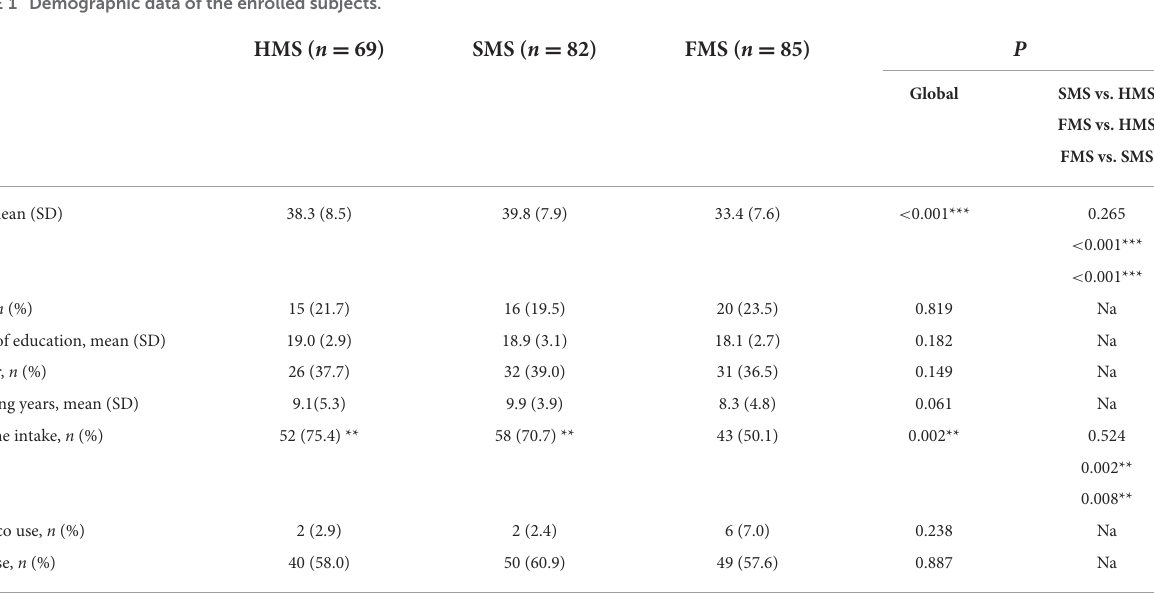
TABLE 1 Demographic data of the enrolled subjects.